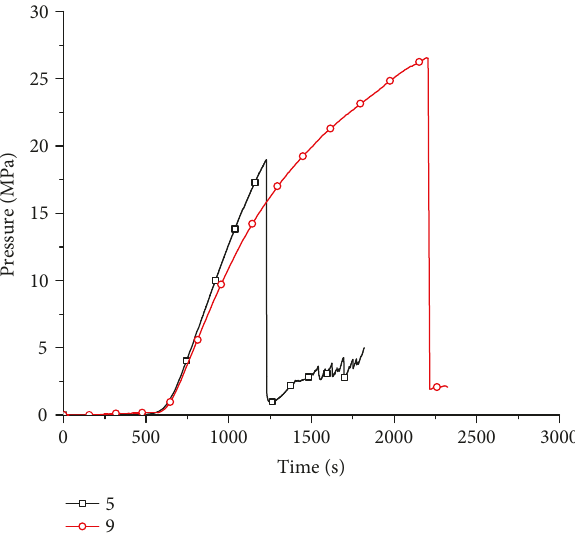
Figure 18: Pressure curves in the core fracturing